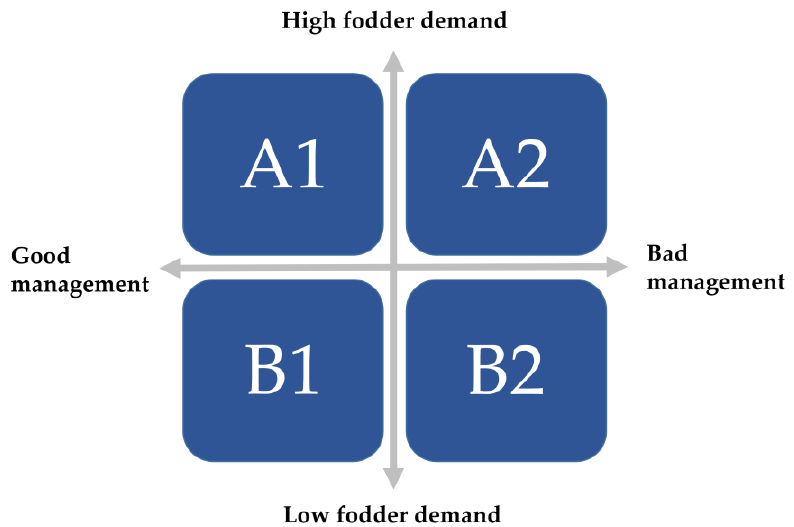
Figure 3. Four scenarios related to the driving forces management and fodder demand: A1 (good management and high fodder demand), A2 (bad management and high fodder demand), B1 (good management and low fodder demand) and B2 (bad management and low fodder demand).